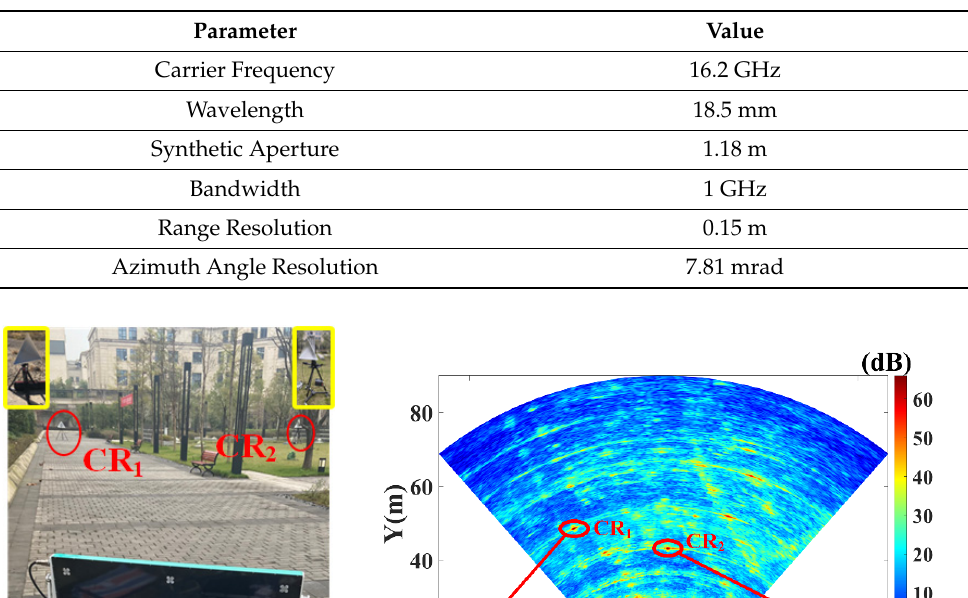
Table 3. Offsets of the radar